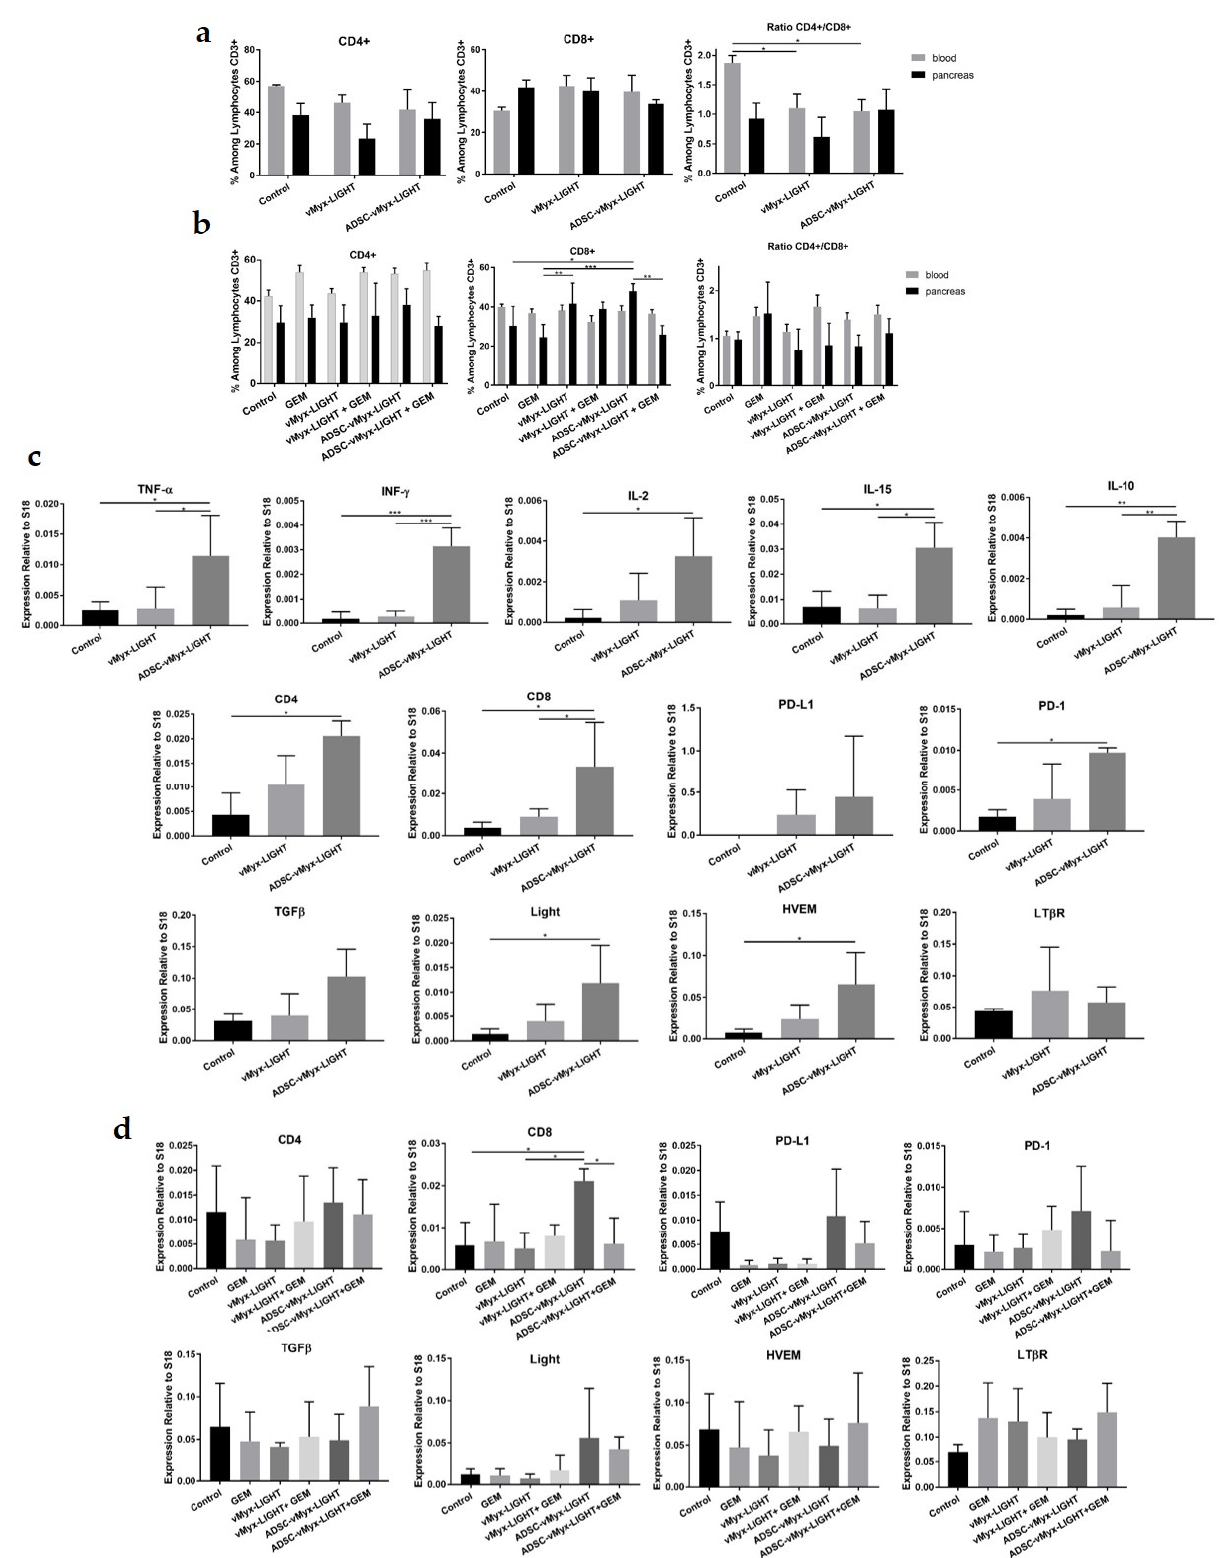
Figure 5. Antitumor immune response after combined therapy of experimental pancreatic adenocarci- noma using LIGHT-armed MYXV construct and GEM. C57Bl/ C57Bl/6NCrl mice ( n = 6) with induced orthotopic lesions were injected ip. (days 4, 6, 8, 10 and 12) with LIGHT-expressing MYXV—either